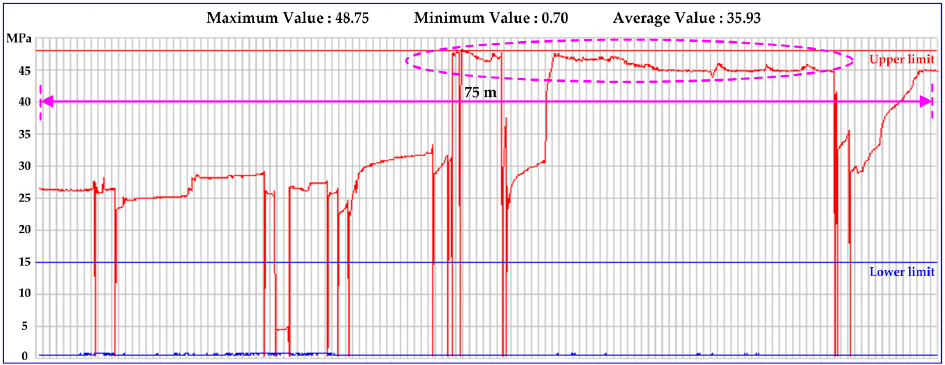
Figure 16. Working resistances on the hydraulic supports (HSs) when the coalface moved 60 m forward.